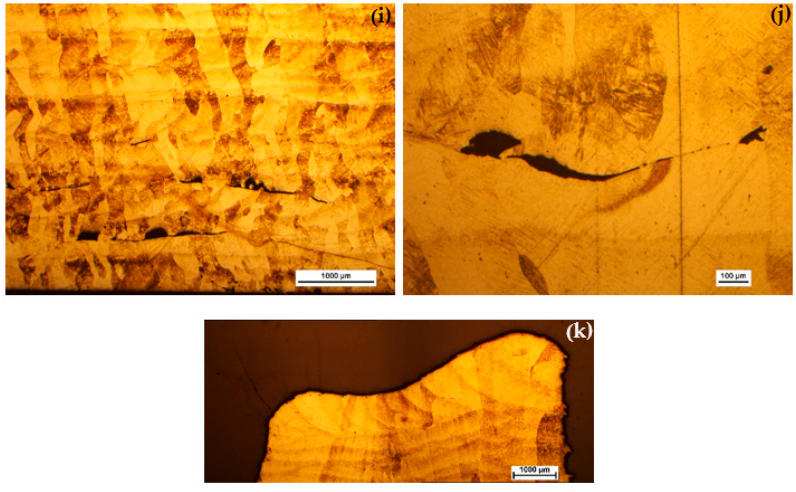
Figure 9. Dimensional and microscopic characterization of the Ti-6Al-4V fitting. Stereomicroscope images revealing distortions and extra build ( a ), surface roughness and partially melted powder particles ( b ). ( c – e ) Optical scanner dimension measurements compared to the designed model. Side ( c ), front ( d ), and back ( e ) views. Scale bars in millimeter units; color scheme: red—lower than the model dimensions, green—exactly in the model dimensions, and blue—higher than the model dimensions. ( f , g ) Non-etched metallographic cross-sections through the bore area reveal partially melted powder particles on the inner wall of the bore ( f ) and significantly higher porosity in the fitting zone adjacent to the substrate plate ( g ). ( h ) After chemical etching, a fine acicular α ’ microstructure and a prior β grain boundary (marked by arrow) are evident. ( i ) A columnar microstructure with the prior grains oriented parallel to the built direction and an interlayer lack of fusion. ( j ) HAZ and interlayer lack of fusion adjacent to the substrate plate. ( k ) HAZ, extra build, and interlayer boundaries around the bore.